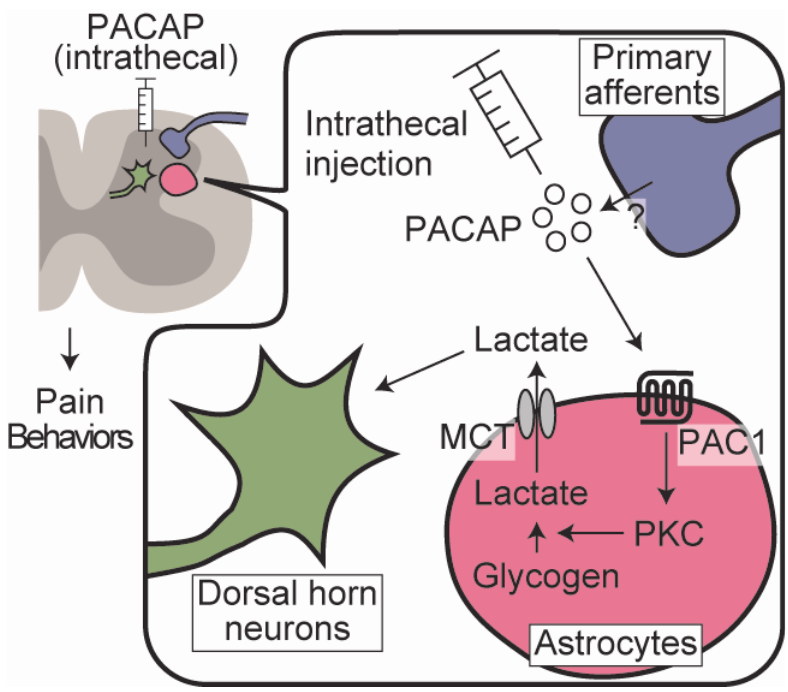
Figure 8. Schematic illustration of the present study.